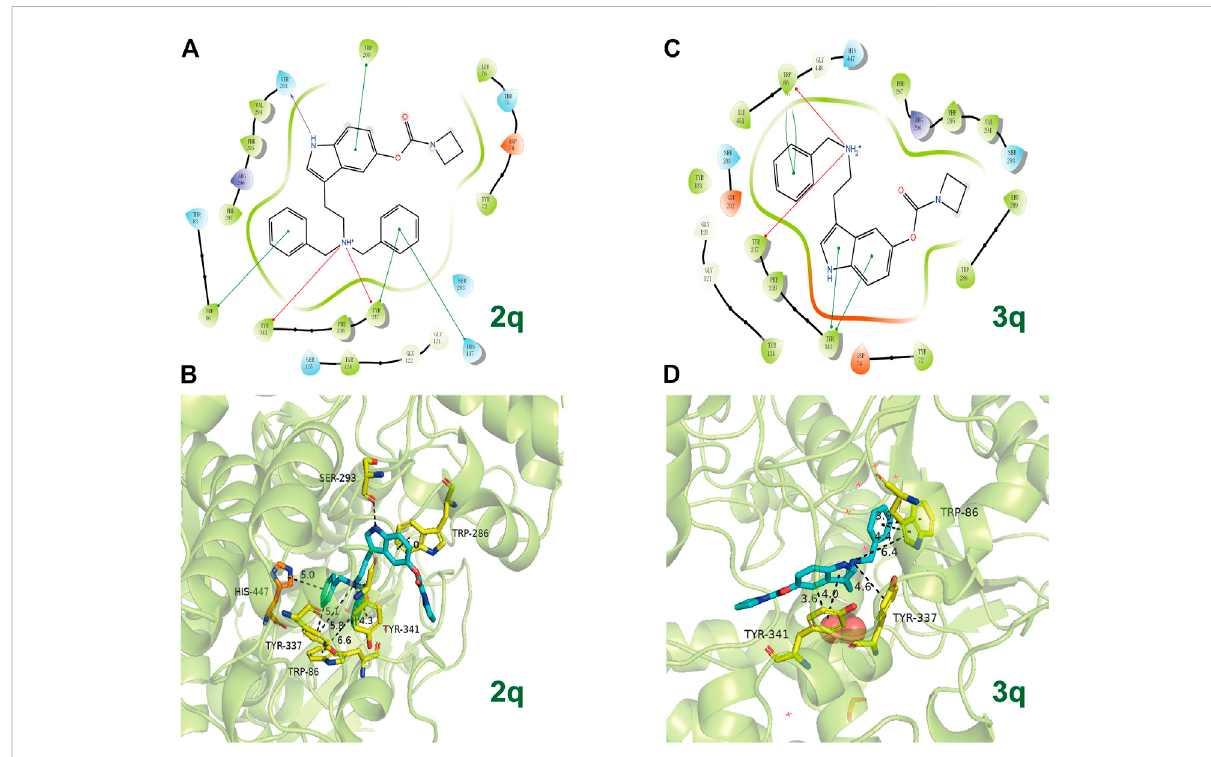
FIGURE 6 Thepossiblebindingmodeforthecompounds 2q and 3q intheAChE(PDBcode:4M0F)bindingsites. (A,C) The2Dimagesof 2q and 3q binding toAChEpredictedbySchrodingersoftware(Release2019-2,Schrodinger,LLC,NewYork,NY,2019).Thepurplearrowindicateshydrogenbond,the red arrow indicates π – cation interaction, and the green line indicates π – π stacking interaction. (B,D) The 3D images of 2q and 3q binding to AChE polishedbyPymol(http://www.pymol.org).ResiduesoftheCAS(His447)areshowninorange,andtheresiduesofPAS(Ser293,Trp286,Tyr337, Trp86, and Tyr341) are shown in yellow. The dashed lines indicate hydrogen bond interaction, π – π stacking interactions, or π cation